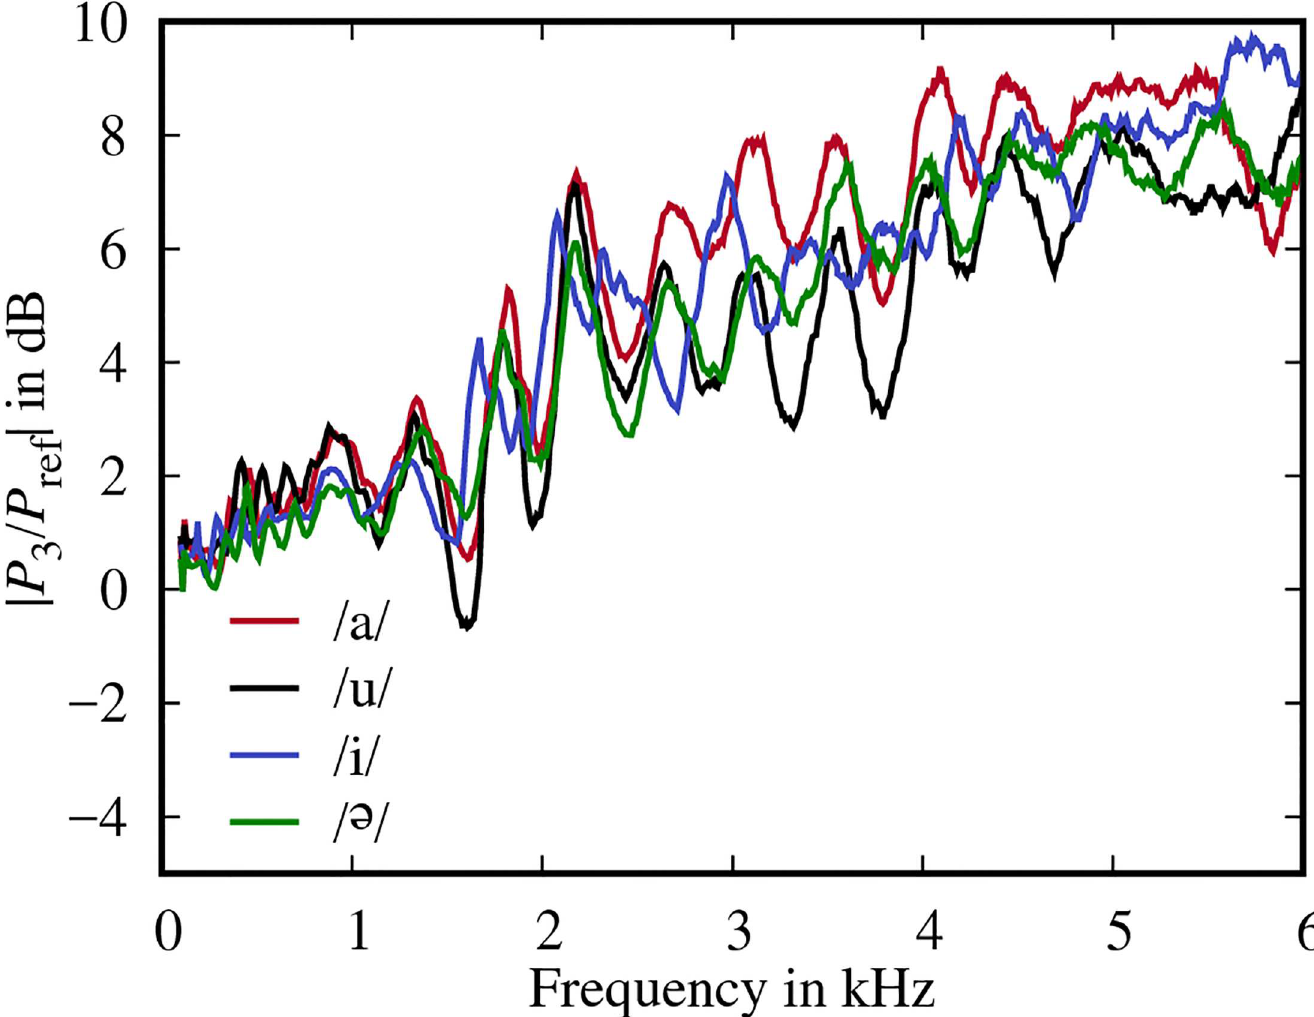
Fig 5. Experimentally determined pressure ratios at the lips. Ratio of the pressure spectra measured in front of the closed mouth ( P 3 ) and without the models ( P ref ) for all four models.